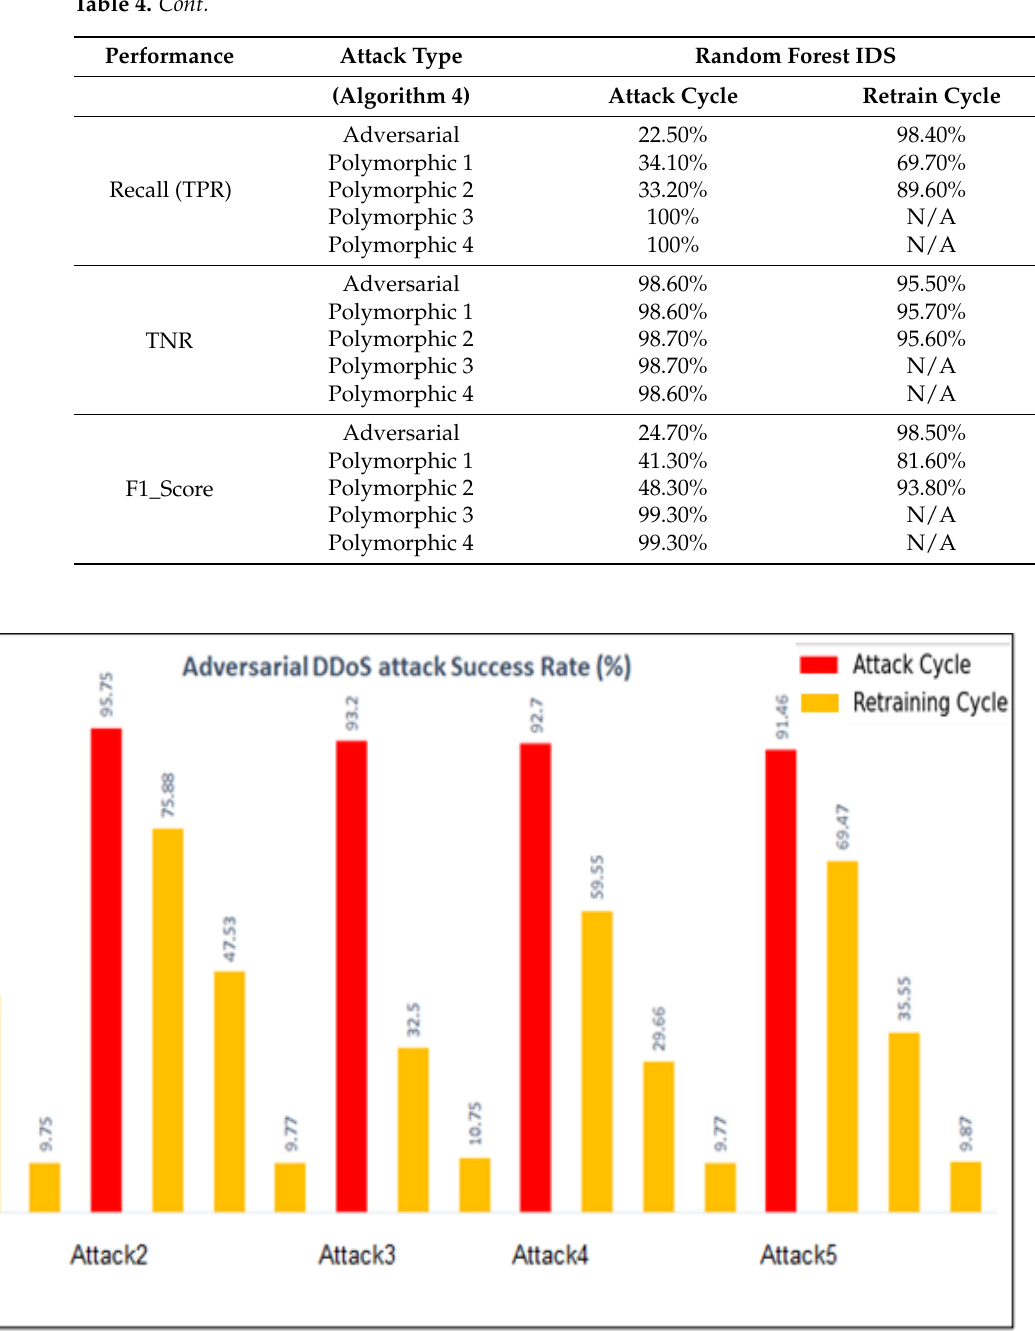
Figure 9. Polymorphic adversarial attacks using the manual feature selection (20 features).